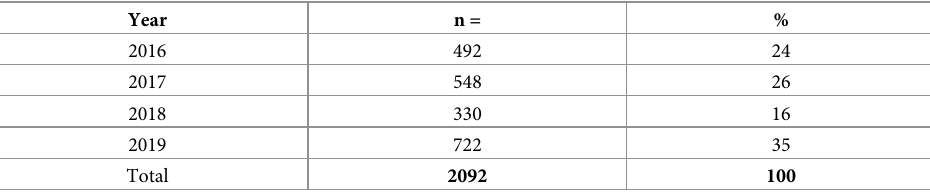
Table 2. Sample frame distribution by year of data collection.